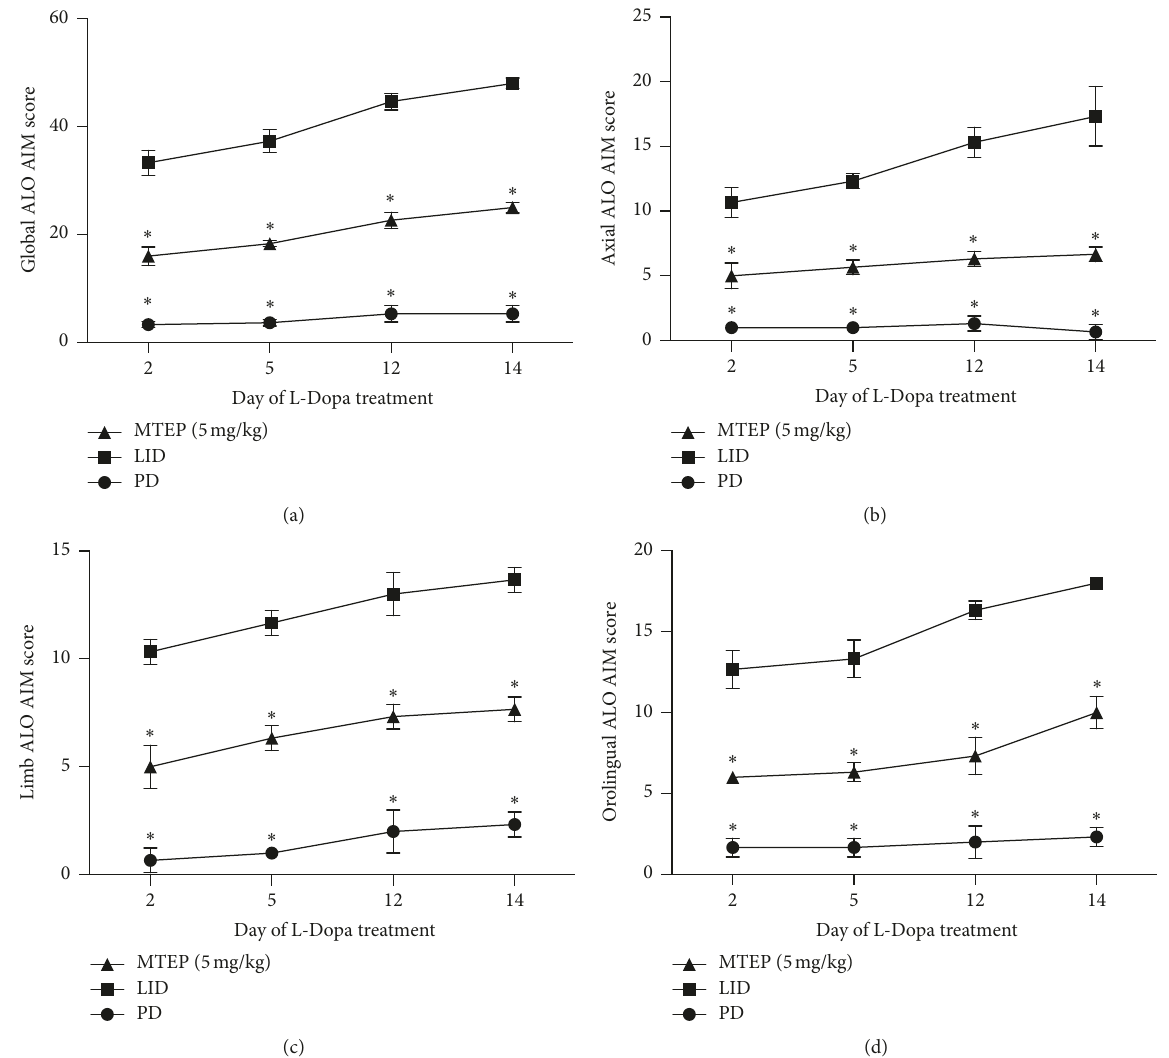
Figure 2: Effect of MTEP on the AIM scores. 14 days’ use of MTEP significantly reduced AIM scores. At the 2nd, 5th, 12th, and 14th days, a total AIM score was calculated as the sum of the basic scores multiplied by the amplitude of the score for each AIM subtype: limb, orolingual, and axial, excluding the rotation subtype. (a) Time course of the total scores; sum of the axial, limb, and orolingual subtype scores; (b) time course of changes in the axial scores; (c) time course of changes in the limb score; and (d) time course of changes in the orolingual score. In each testing session, the AIM scores were rated following the administration of the drugs. Data are presented as the mean ± SD. ∗ 𝑝 < 0.01 versus the LID group (Kruskal-Wallis test followed by Dunn’s test for multiple comparisons or Mann–Whitney 𝑈